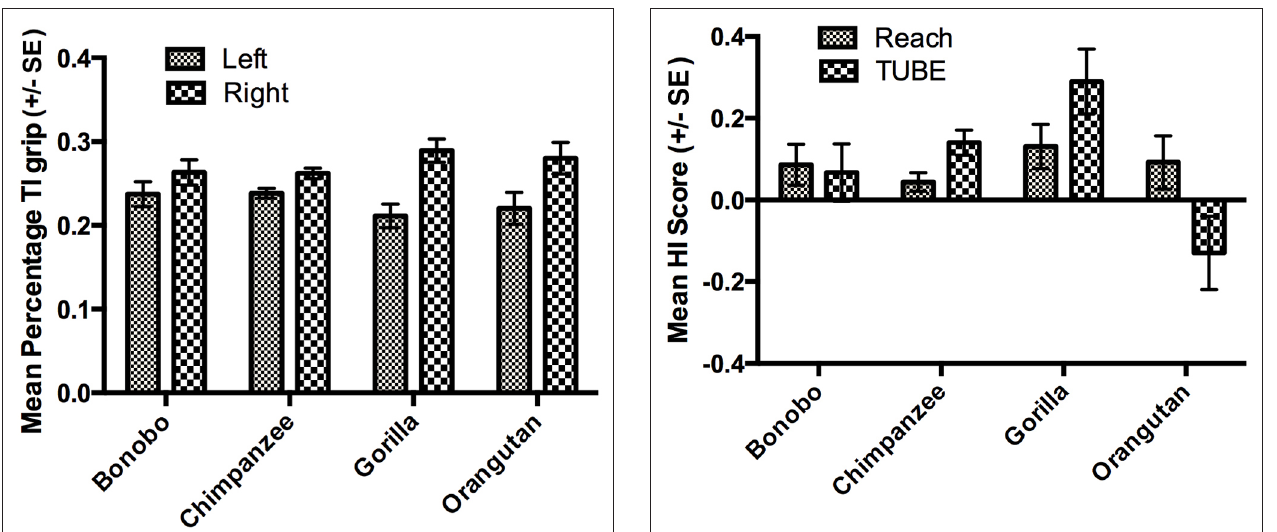
FIGURE 3 | Mean HI scores ( (cid:6) SE) for the TUBE and Reaching tasks in each species. The sign of Mean HI scores indicates the direction of the manual bias (negative value: left-hand bias, positive value: right-hand